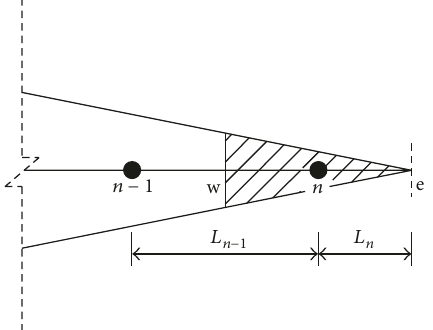
Figure 6: Boundary conditions for fluid front.